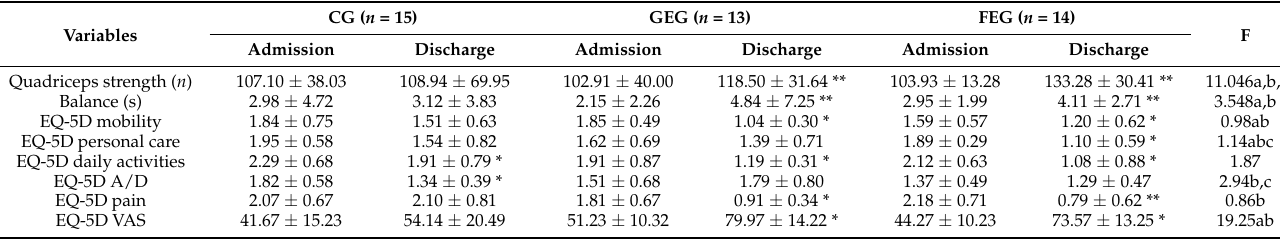
Table 3. Main outcomes from admission to discharge in each